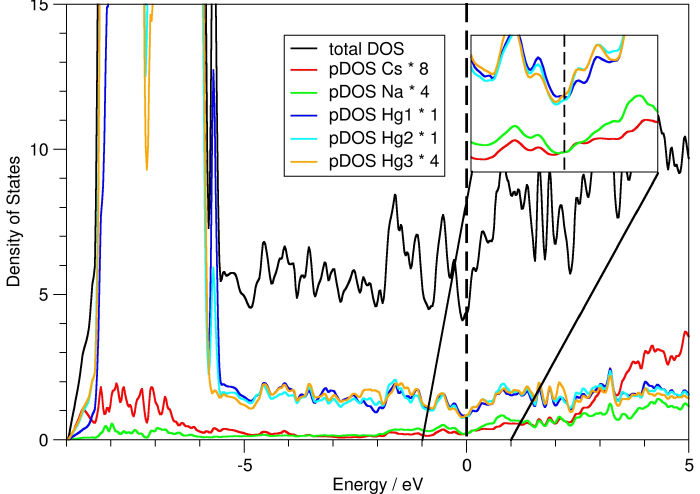
Figure 4. Density of states (DOS) and partial density of states (pDOS) curves for CsNa 2 Hg 18 and the individual atomic sites therein. The Fermi energy is marked as a dashed vertical line. The region ± 1 eV around the Fermi energy is magnified in the inset.